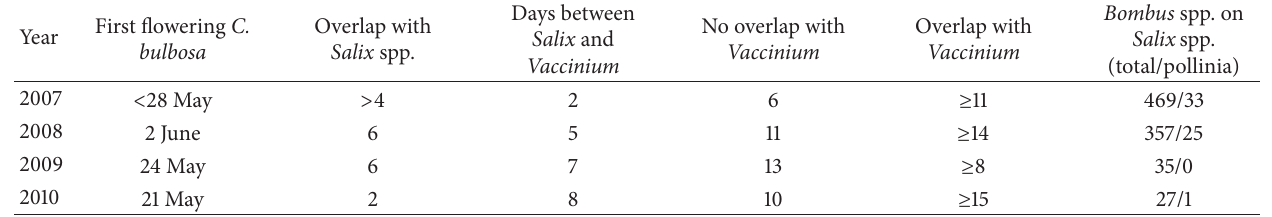
Table 1: The phenological window of Calypso bulbosa flowering in relation to the flowering of the most important nectar sources, early flowering willows ( Salix ) and later-flowering bilberry ( Vaccinium ). Overlap of C. bulbosa flowering with the coflowering species is given in number of days. The last column gives total number of Bombus spp. on Salix spp. and number of individuals carrying pollinia. Days between Bombus spp. on First flowering C. Overlap with No overlap with Overlap with Year Salix and Salix spp. bulbosa Salix spp. Vaccinium Vaccinium Vaccinium (total/pollinia) 469/33